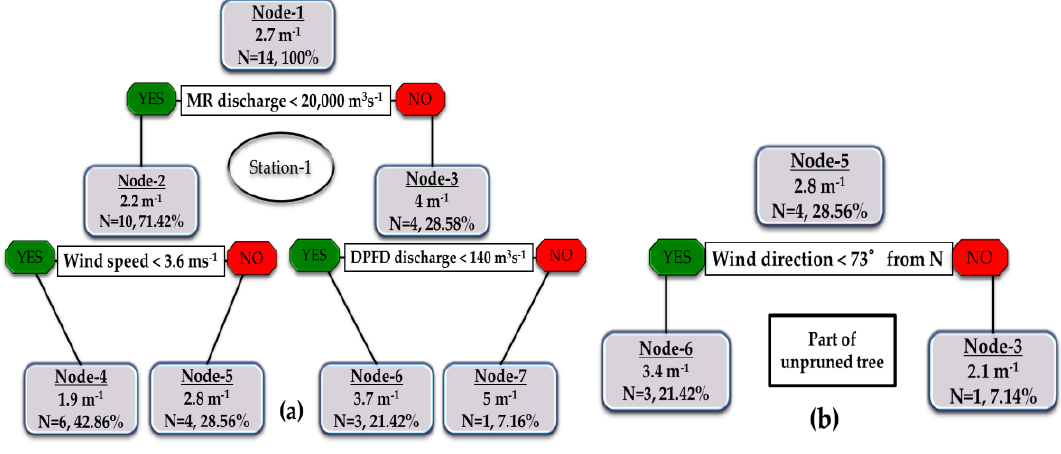
Figure 6. (a) Decision tree for a g 355 at Station 1. The groups are represented by mean, number of samples (months) and percentage (%) of total measurements. (b) Part of the unpruned tree shows the influence of northerly winds at